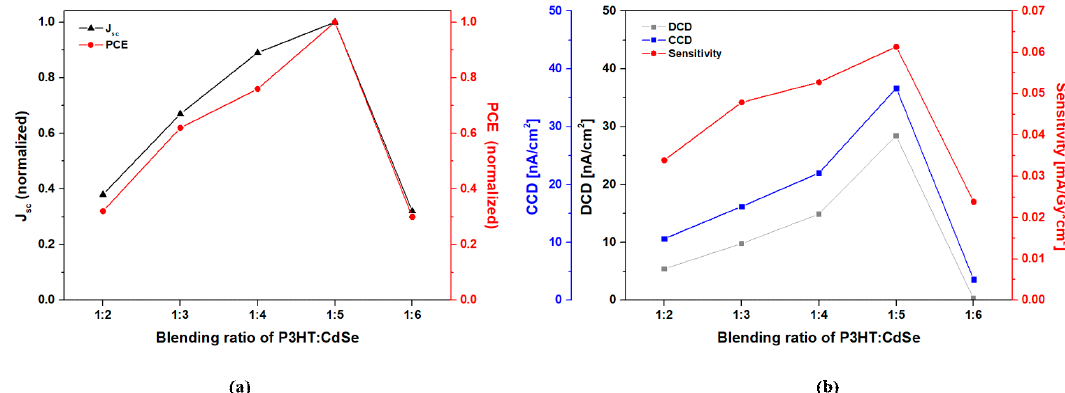
Figure 5. ( a ) The normalized solar parameters (J SC and PCE), and ( b ) radiation parameters (CCD, DCD, and sensitivity) of the detectors with different blending ratios of 1:2, 1:3, 1:4, 1:5, and 1:6 of the P3HT:CdSe QDs active layer.